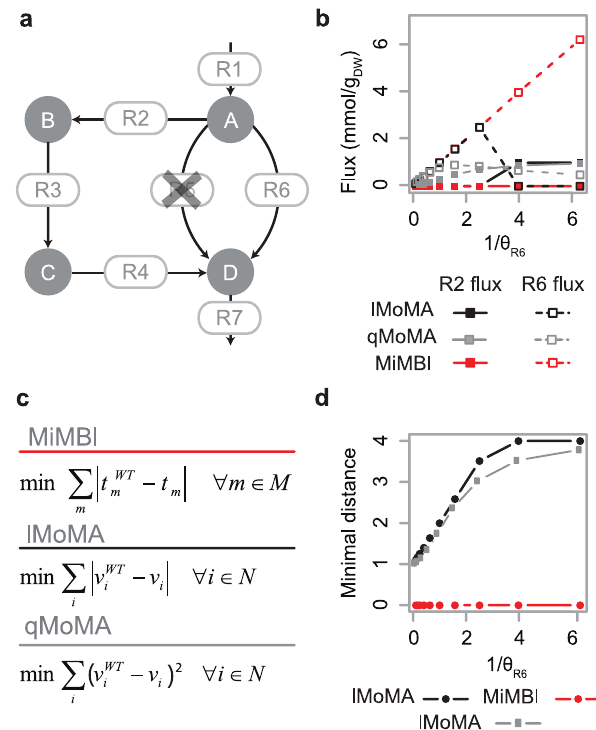
Figure 2. MiMBl shows robust simulation results while using alternative stoichiometry representations – illustration using a toy-model. a ) Toy-model: R1 to R7 and A to D represent reactions and metabolites, respectively. In the wild-type, or reference, flux goes from A to D via R5 . R6 and R2–R3–R4 are two alternative pathways for flux re- distribution after deletion of R5 . b ) Flux through reactions R2 (full symbols) and R6 (open symbols) obtained after simulation of minimization of metabolic adjustment with lMoMA (black), quadratic MoMA (qMoMA, gray) and MiMBl (red) using numerically different but biochemically equivalent representations of reaction R6 (given by different scaling factor h R6 , Methods ). c ) Formulation of objective functions of minimization of metabolic adjustment for lMoMA, qMoMA and MiMBl ( Methods ). d ) Optimal objective function value (distance) obtained for minimization of metabolic adjustment using lMoMA (black), qMoMA (gray) and MiMBl (red) as function of h R6 .